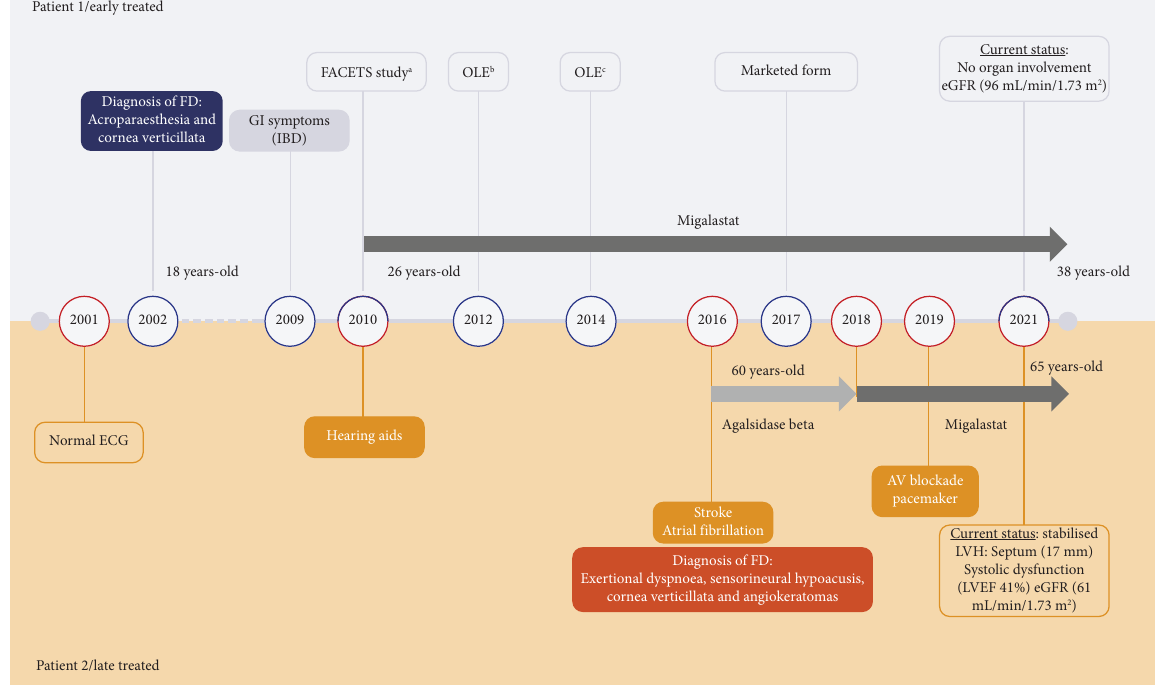
Figure 3: Medical history and occurrence of events over time in two female patients treated at diferent stages of FD. a AT1001-011 (NCT00925301), b AT1001-041 (NCT01458119), and c AT1001-042 (NCT02194985). AV, atrioventricular; ECG, echocardiogram; eGFR, estimated glomerular fltration rate, normal: > 90 and > 60 for omen > 50 years 15 ; FD, Fabry disease; GI, gastrointestinal; IBD, irritable bowel syndrome; LVEF, left ventricular ejection fraction; LVH, left ventricular hypertrophy; OLE, open-label